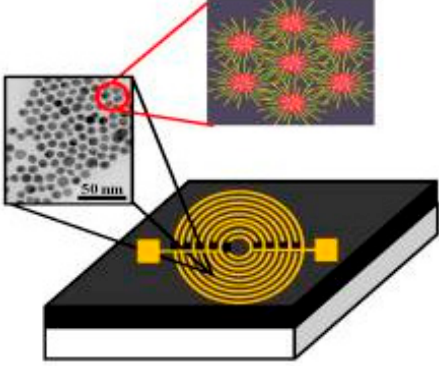
Figure 24. Schematic representation of the gold nanoparticle (GNP) sensors in this study (not drawn to scale). The sensors were formed by successively drop casting the solutions of the molecularly modified GNP solutions onto 10 pairs of pre-prepared Ti/Au-inter-digitated electrodes. The left inset in the sensor’s schematics shows a tunnelling electron micrograph (TEM) of the NPs, which connects the electrodes and forms multiple paths between them. The right inset of the sensor’s schematics shows schematics of films based on molecularly modified GNPs. In these films, the metallic particles provide the electric conductivity, and the organic film component provides sites for the sorption of analyte (guest) molecules. In addition to their role as an adsorptive phase, the presence of well- defined organic spacers (i.e., capping molecules) allows a control over the inter-particle distance, and thereby, obtaining nearly uniform inter-particle distances in the composite films. This allows achieving controlled signal and noise levels. Used with permission from [125].